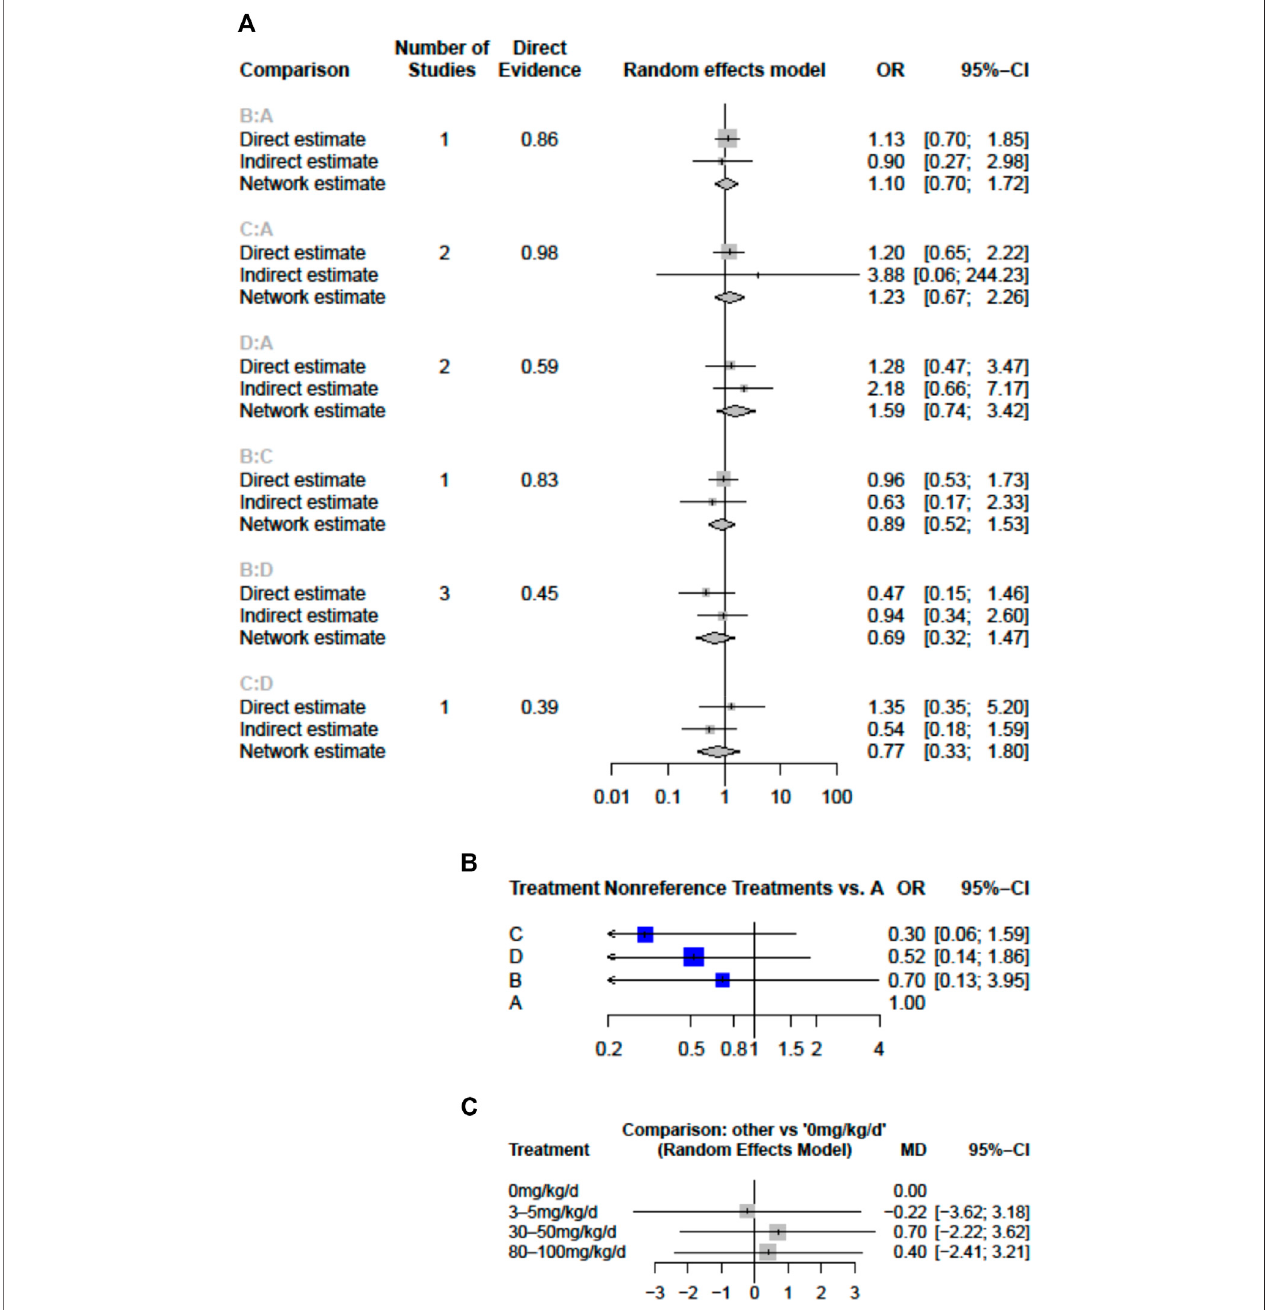
FIGURE 3 | Forest plots of network meta-analysis for the effects of aspirin doses on (A) the risk of coronary artery lesions (CAL) (B) the risk of intravenous immunoglobulin (IVIG) resistance (C) hospital stays (mean difference in days) (A) , aspirin 0 mg/kg/day (B) , 3 – 5 mg/kg/day (C) , 30 – 50 mg/kg/day; D, 80 – 100 mg/kg/ day; CI, con fi dence interval; d, day; OR, odds